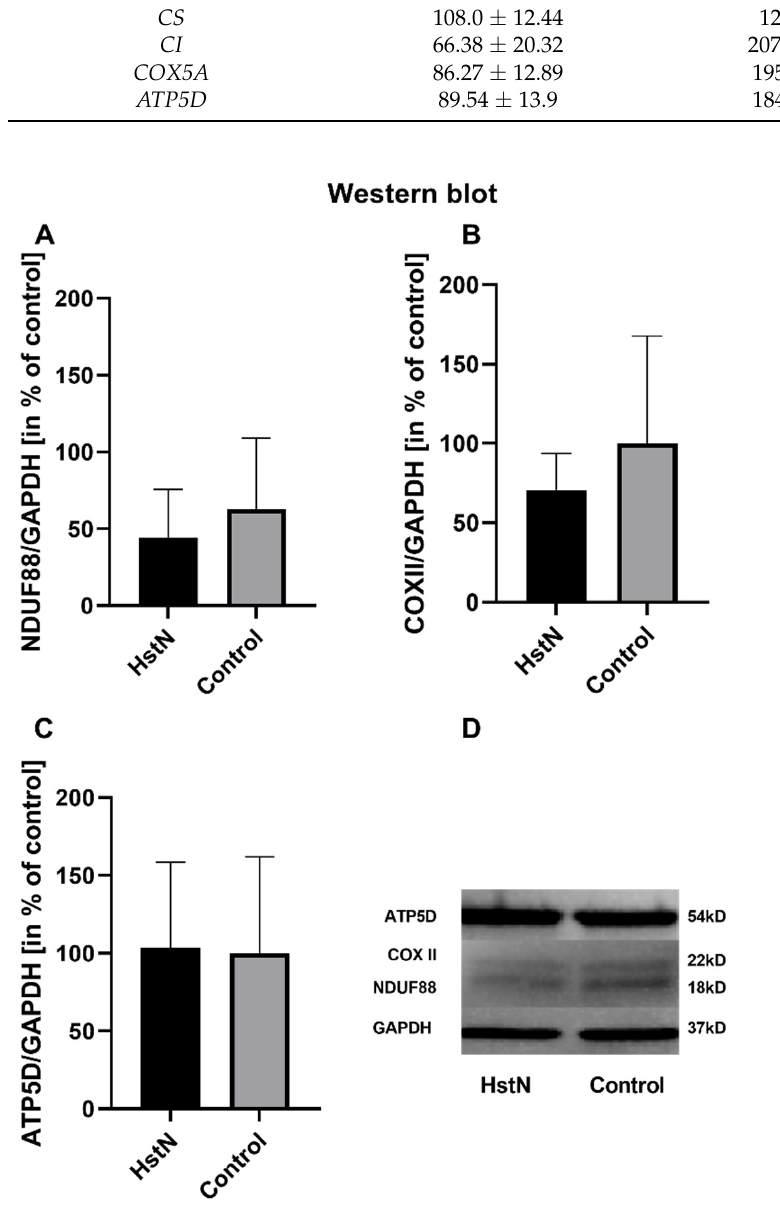
Figure 4. Western blot analysis of mitochondrial respiratory chain complexes of five experiments. Protein levels of ( A ) complex I subunit NDUF88 , ( B ) complex IV subunit COXII , and ( C ) complex V subunit ATP5D in % of control after incubation with 10 µM HstN or PC (control) in SH-SY5Y-APP 695 cells. ( D ) Lower part: representative Western blots of one experiment. GAPDH served as loading control. Respective mean values ± SD are shown. Significance was determined by Student’s unpaired t-test. HstN, hesperetin nanocrystal. Table 3. Effect of HstN at relative normalized mRNA expression levels in SH-SH-SY5Y-MOCK and -APP 695 cells after incubation with HstN for 24 h, determined using quantitative real-time PCR com- pared to SH-SY5Y cells incubated with PlantaCare (PC). mRNA expression of control cells incubated with PC is set as 100%. Respective mean values ± SD are shown. Significance was determined with unpaired Student’s t-test (* p < 0.05, ** p < 0.01). Calculation of normalization factor based on geo- metric mean of multiple control genes levels of ß-actin ( ACTB ), glyceraldehyde 3-phosphate dehydrogen- ase ( GAPDH ), and phosphoglycerate kinase 1 ( PGK1 ). HstN, hesperetin nanocrystals. Complex